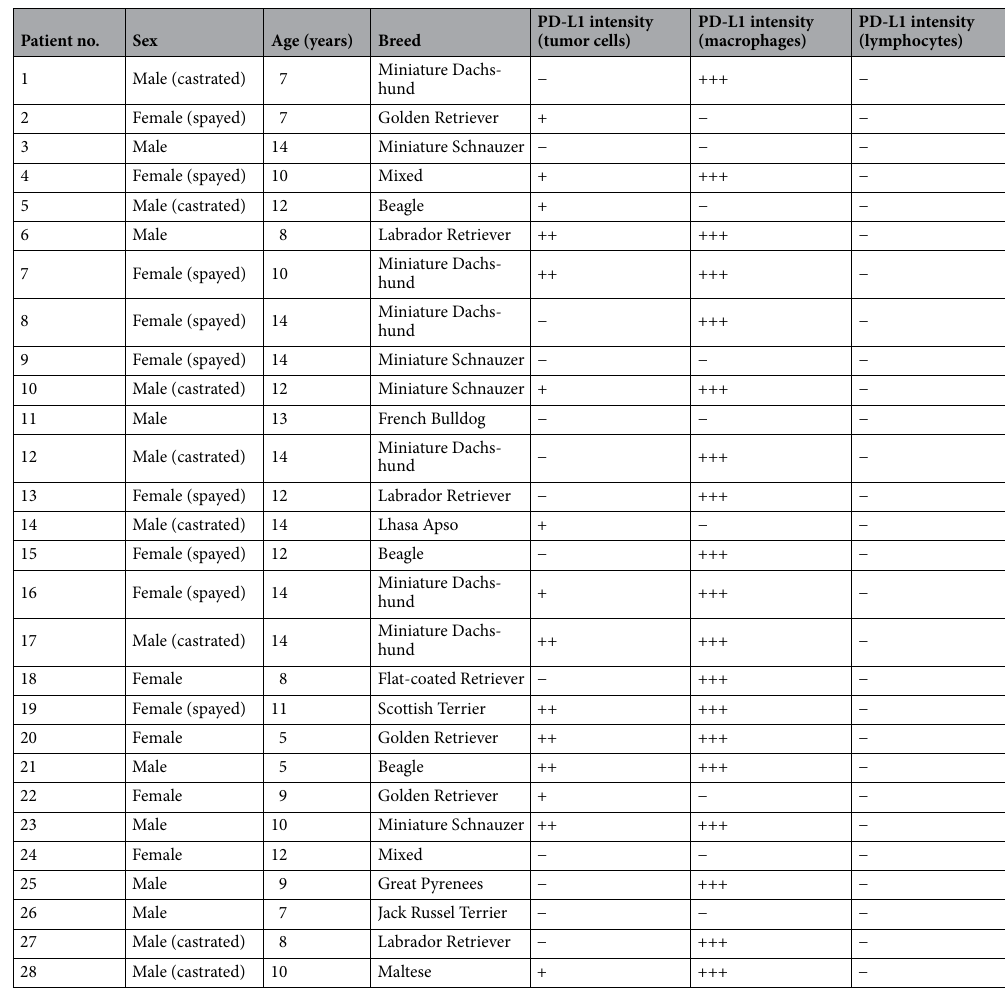
Table 1. PD-L1 expression in tumor and immune cells in canine